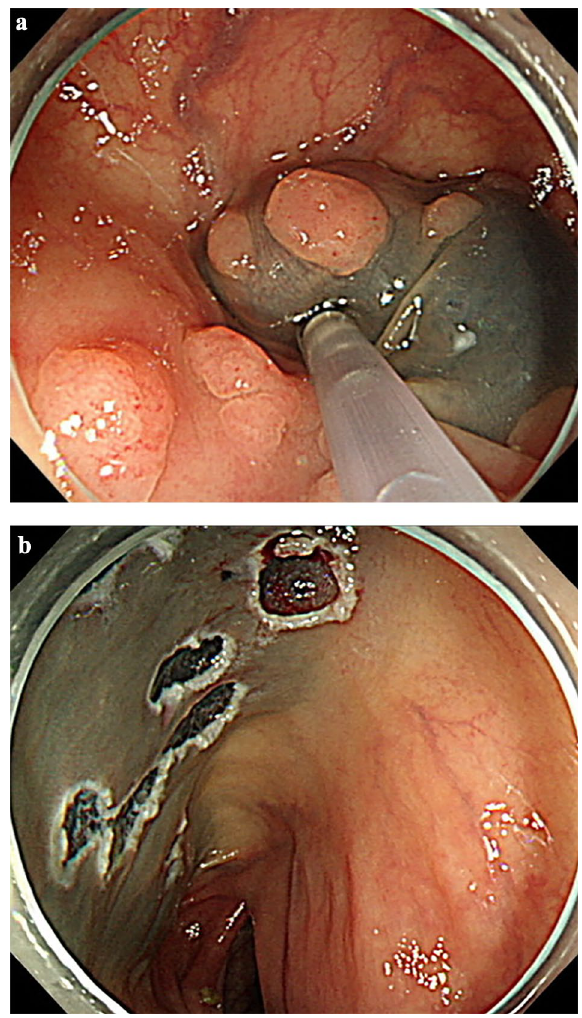
Figure 3. Colonoscopic polypectomy of multiple polyps. ( a ) Endoscopic mucosal resection (EMR) was performed for multiple polyps. ( b ) Multiple post-EMR ulcers were